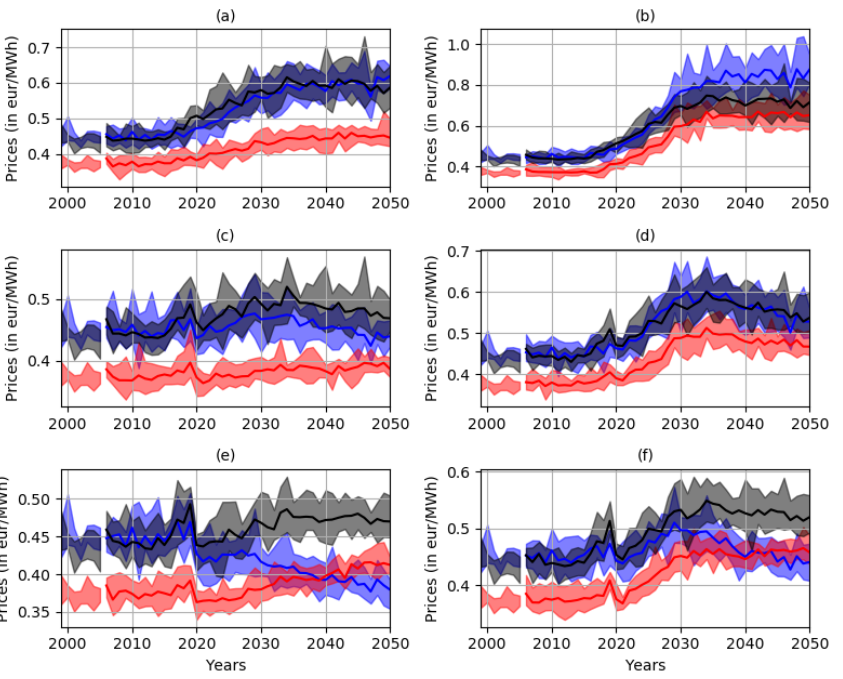
Figure 6. Yearly relative standard deviations of prices for each of the 6 different economic scenarios (blue for France, black for Germany, red for Denmark). Left panels correspond to low penetration scenarios ( a , c , e ) and right panels to high penetration scenarios ( b , d , f ). Top panels correspond to no demand trend scenarios ( a , b ), middle panels to medium demand trend scenarios ( c , d ), and bottom panels to high demand trend scenarios ( e , f